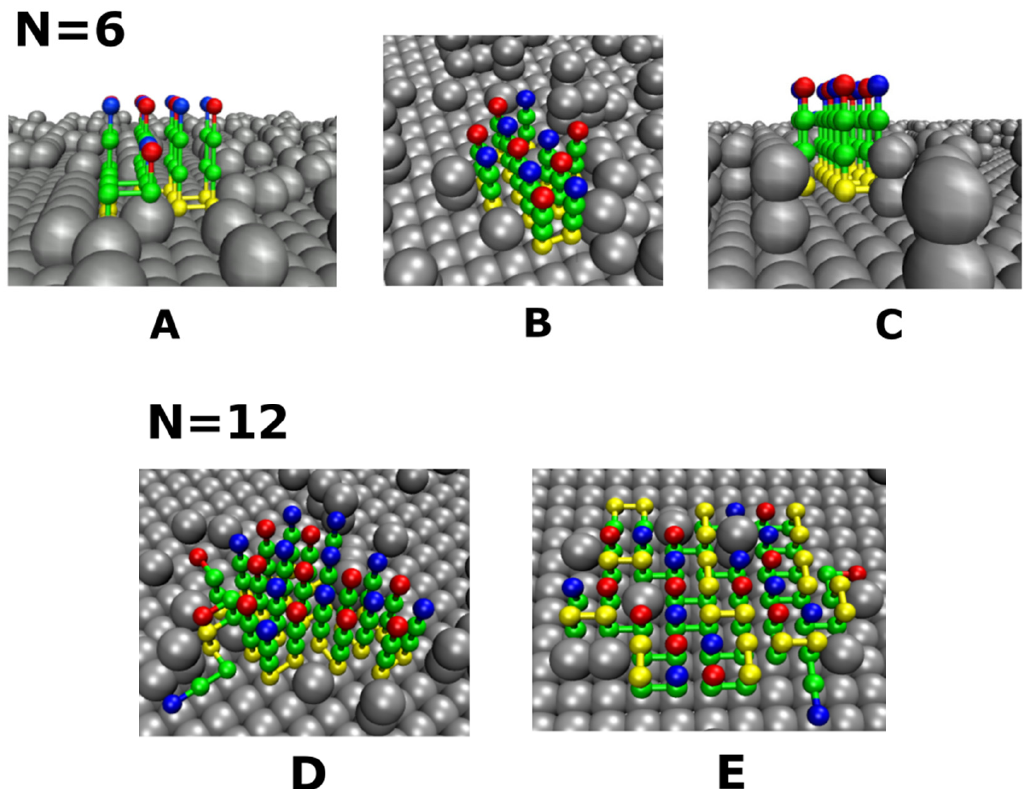
Figure 3. Typical fibril-like structures for the system of N = 6 chains on rough hydrophilic surfaces with single balls (S-surface) ( A ), the combination of single and double balls (DS-surface) ( B ), and double balls (D-surface) ( C ). The fibril-like configuration of 12 chains on the hydrophilic DS- surface ( D ), and hydrophobic DS-surface ( E